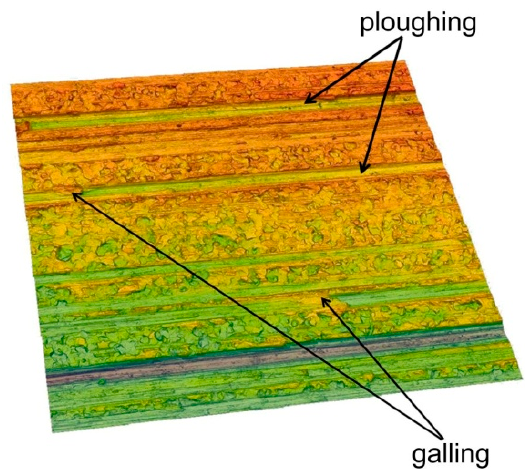
Figure 8. The surface topography of the sheet after a strip drawing test in dry friction conditions, nominal pressure 151 MPa.